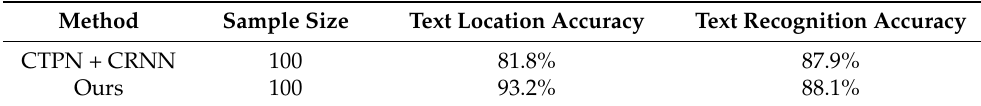
Table 1. Results of pill box identification using traditional and proposed methods.